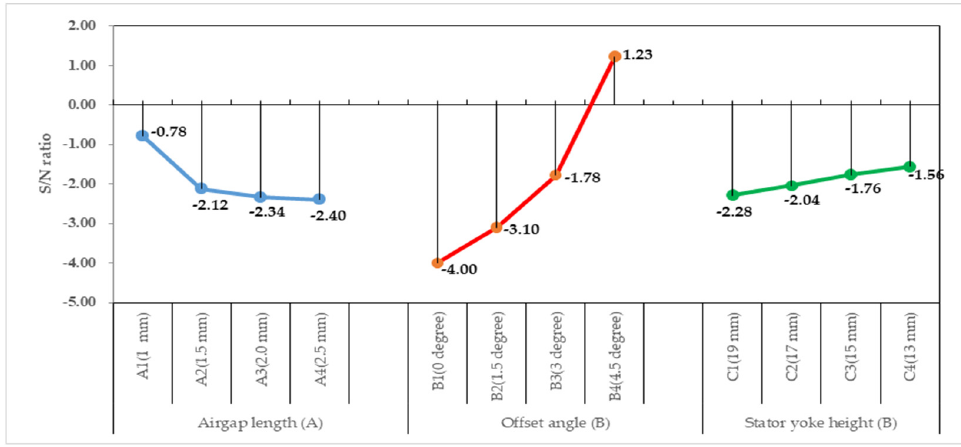
Figure 12. S/N ratio response curve of THD .